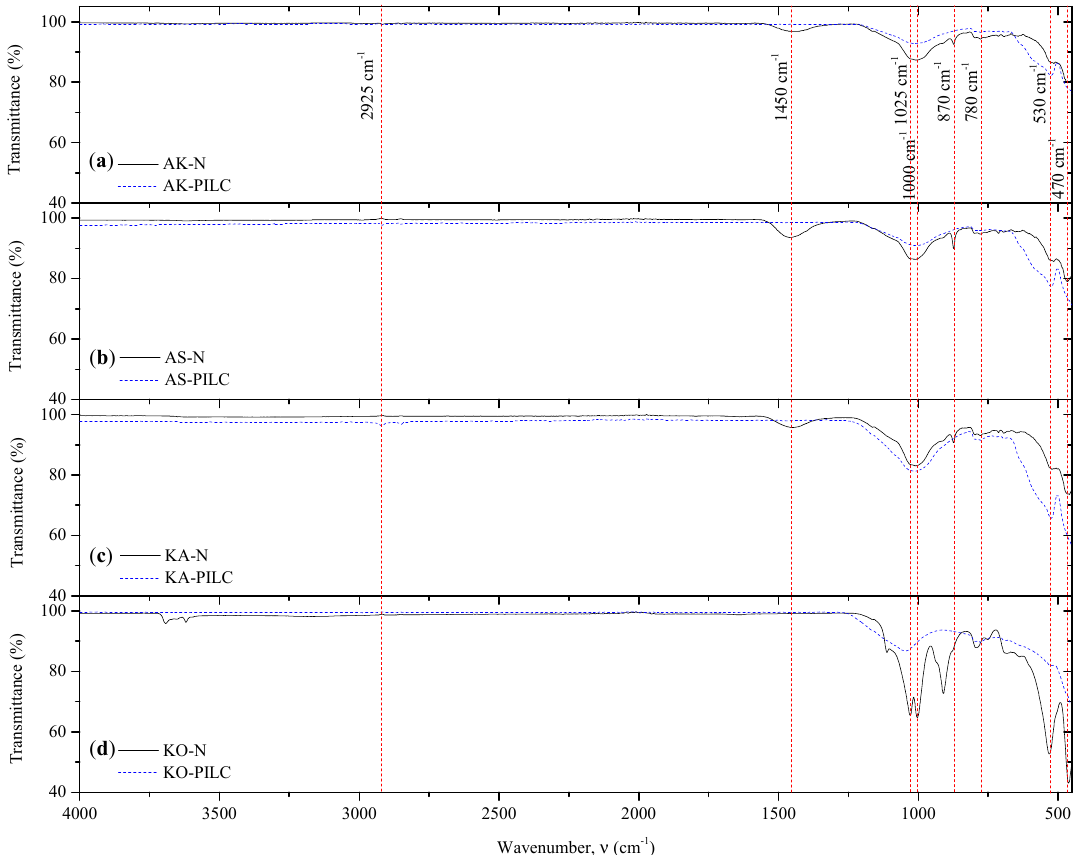
Figure 3. FT-IR spectra of ( a ) Akzhar, ( b ) Asa, ( c ) Karatau and ( b ) Kokshetau based clays in natural and pillared form.